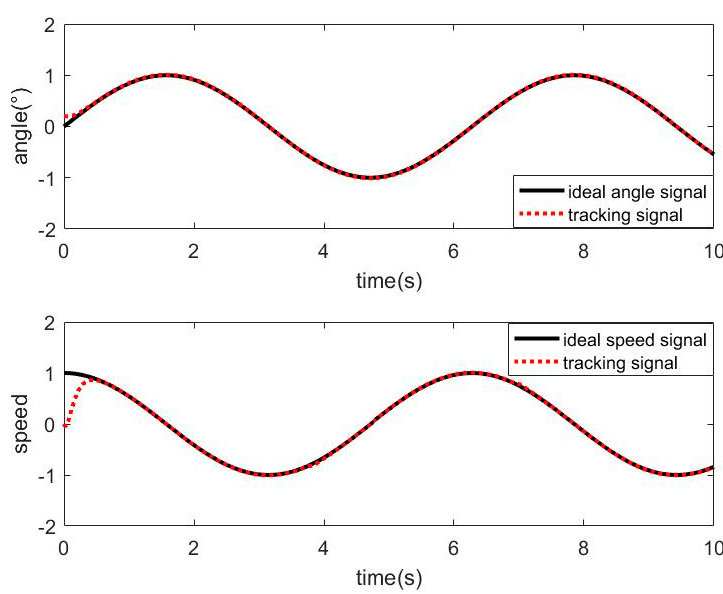
Figure 4. Tracking curve of SMC without friction disturbance.